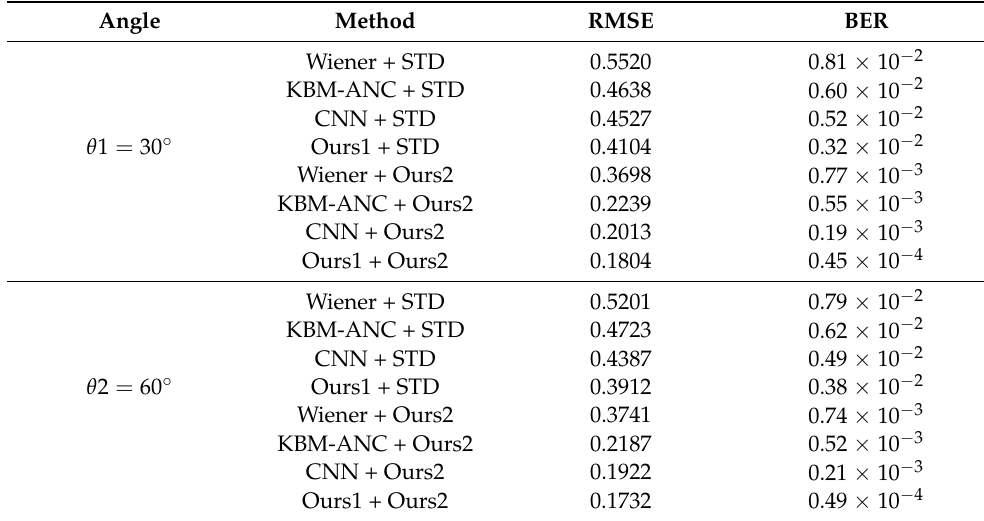
Table 3. RMSE and BER statistics for each joint method in the on-lake experiment. Angle Method